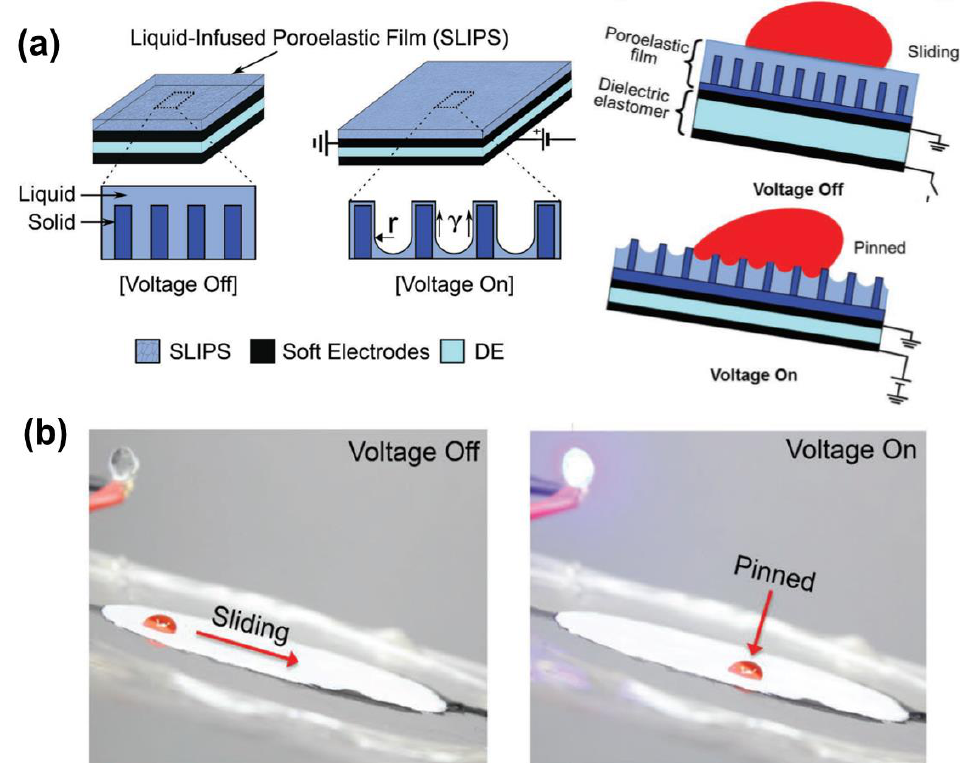
Figure 8. ( a ) Schematic illustration of electric-stimuli LIS and the droplet control mechanism. This smart LIS is integrated with the soft electrodes-sandwiched dielectric elastomer. The droplet initially slides on the tilted LIS in the presence of the lubricant layer when voltage is off. However, after applying a voltage, the poroelastic polypropylene is electrically stretched to reduce the pressure inside the pores, so the lubricant layer disappears and thereby, the droplet directly contacts the protrusions which leads to the droplet pinning. ( b ) Demonstration of the control of the mobility of a 50 µ L droplet on a dynamic silicone-oil-infused polypropylene porous film tilted at 7° by loading/unloading 12 kV voltage. Reproduced with permission [49]. Copyright 2018, Wiley-VCH.